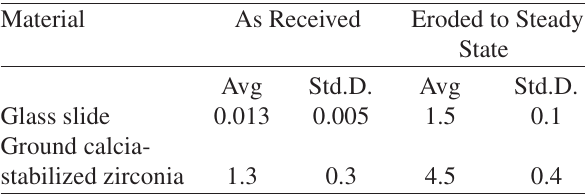
Table 4. Average Roughness of erosion coupons ( µ